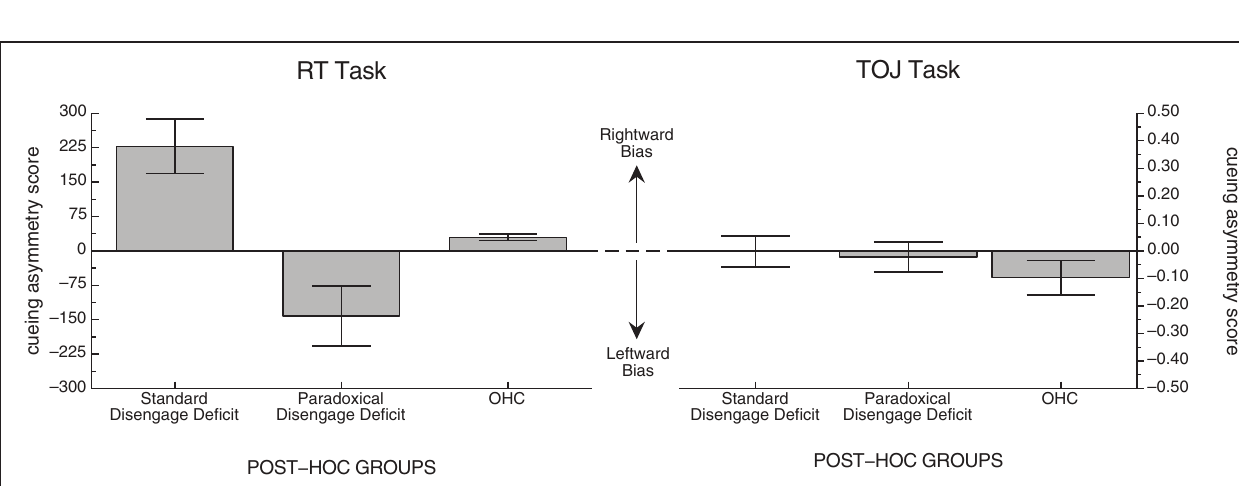
Frontiers in Human